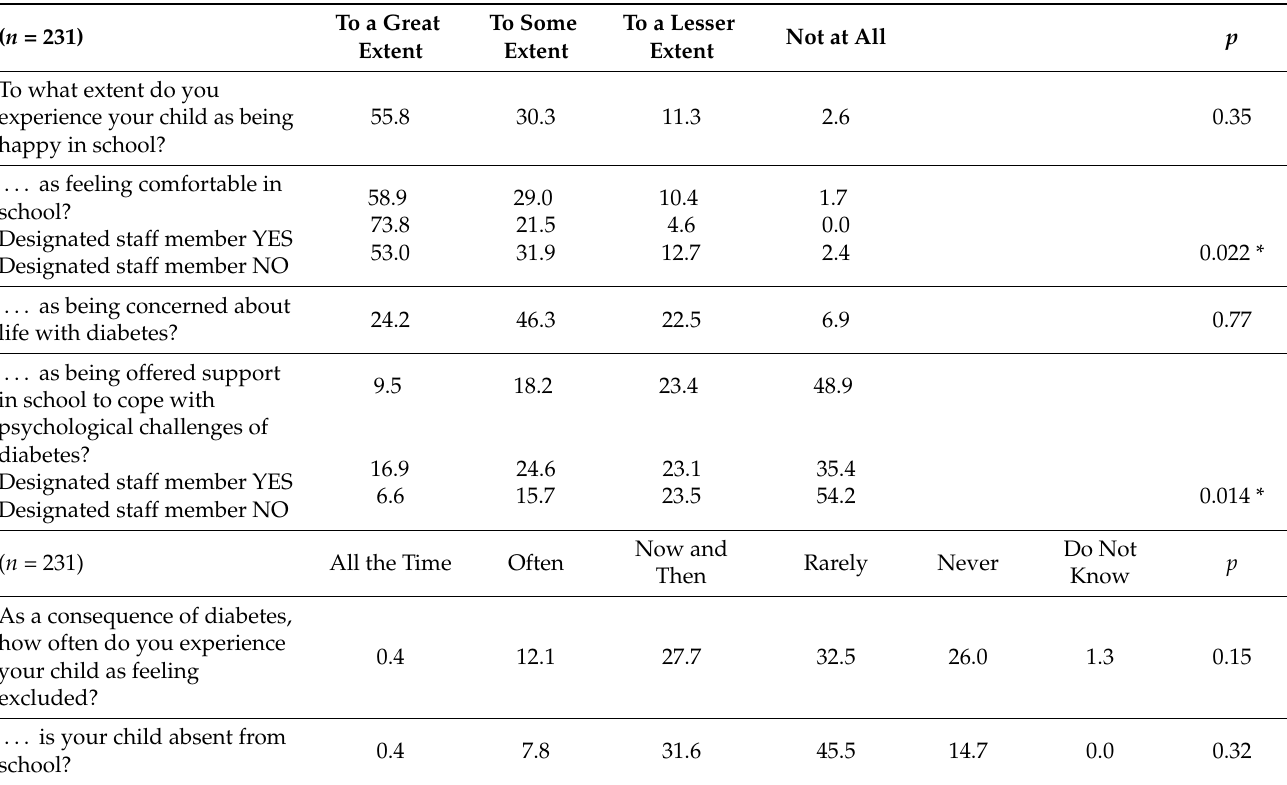
Table 5. A selection of questions and answers within the theme: Indicators of mental health and well-being in school. All questions are worded with emphasis on the time prior to the COVID-19 pandemic. The answers are presented in total frequencies (%) and significant associations ( p < 0.05), stratified for status for designated staff member (YES/NO), are also